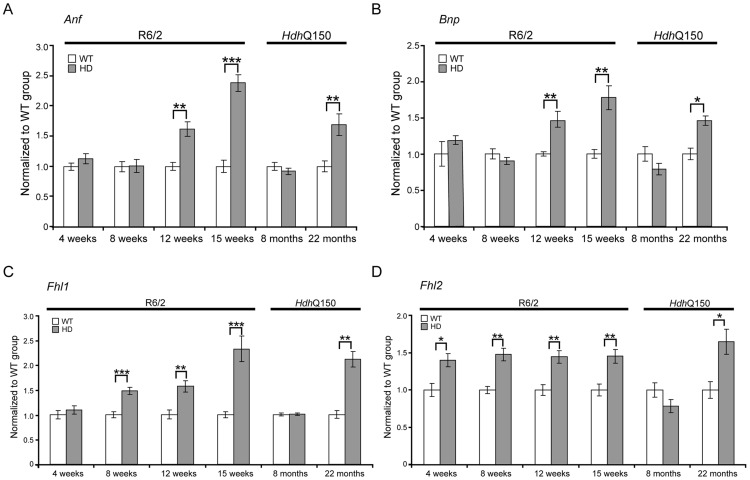
Activation of foetal gene markers in the hearts of R6/2 and HdhQ150 mice.(A) Anp (atrial natriuretic peptide), (B) Bnp (brain natriuretic protein) and (C, D) members of the four and half LIM family Fhl1 and Fhl2 were elevated in the heart of R6/2 and HdhQ150 mice. All Taqman qPCR values were normalized to the geometric mean of three housekeeping genes: Actb, Cyc1 and Gapdh. Error bars are SEM (n = 6). Student's t-test: *p<0.05, **p<0.01; ***p<0.001.